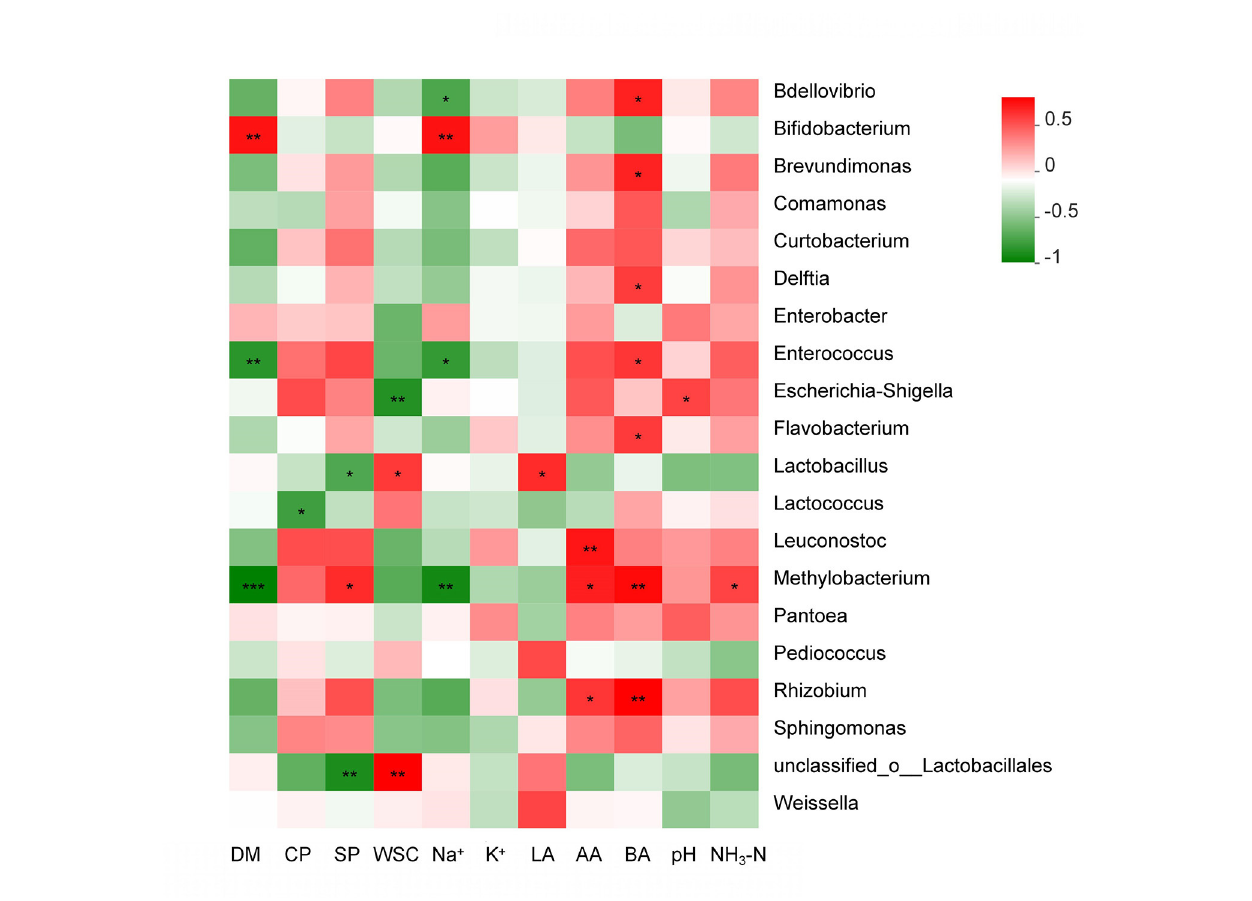
FIGURE 6 | Relevance analysis of high-throughput sequencing data related to the genus level (20 most abundant); DM, dry matter; CP, crude protein; SP, soluble protein; LA, lactic acid; AA, acetic acid; BA, butyric acid; NH 3 -N, ammonia nitrogen; WSC, water-soluble carbohydrates. The legend on the right is the color interval of different R values. * 0.01 < p ≤ 0.05, ** 0.001 < p ≤ 0.01, *** p ≤